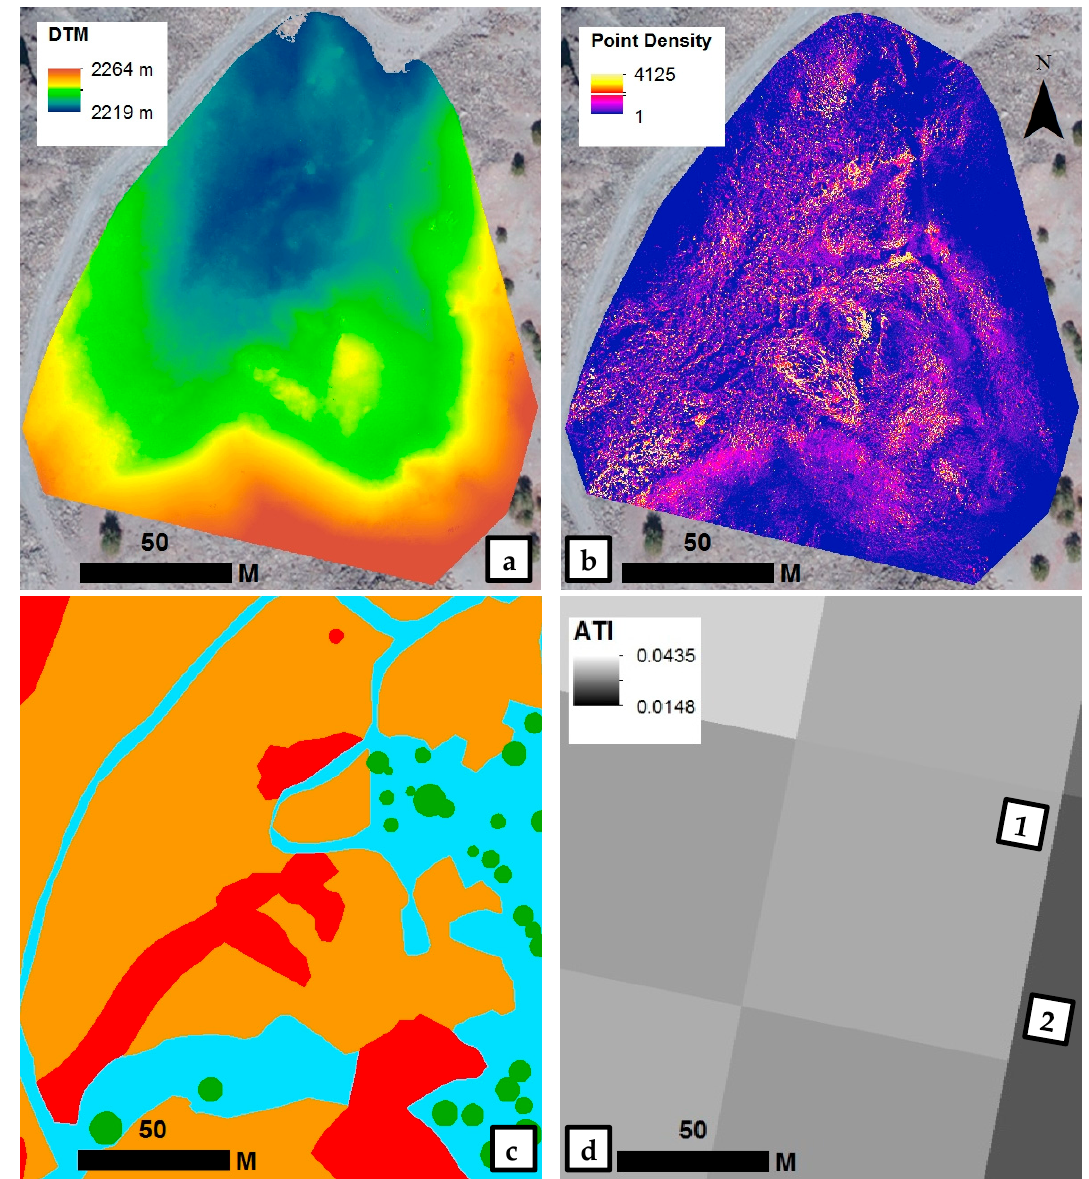
Figure 5. “The Bowl” study site on North Coulee with overlays of the ( a ) digital terrain models (DTM) and ( b ) point cloud density derived from the photogrammetry dataset. ( c ) Visual categories defined using the WorldView-2 data, with red = coarse, orange = moderate, blue = fine, and green = vegetation. ( d ) ATI product at the pixel scale (90 m) with pixel 1 and 2 shown illustrating that “the Bowl” encompasses multiple pixels.